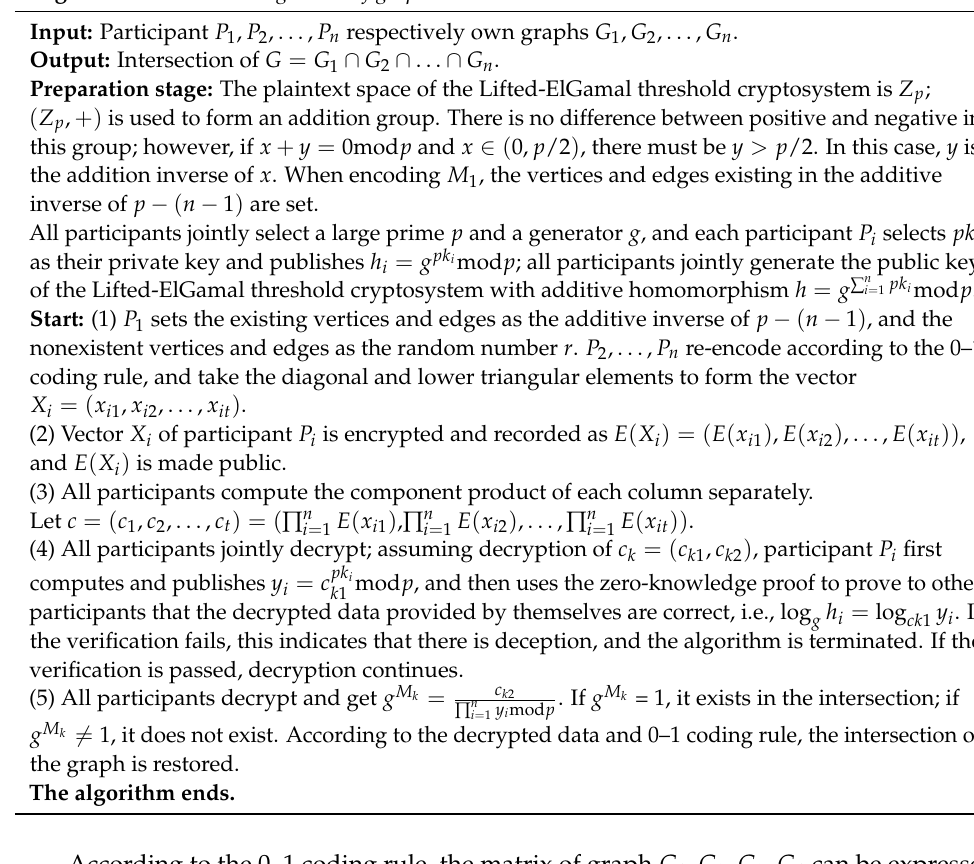
Algorithm 2. The MPC algorithm of graphs’ intersection under the malicious model.